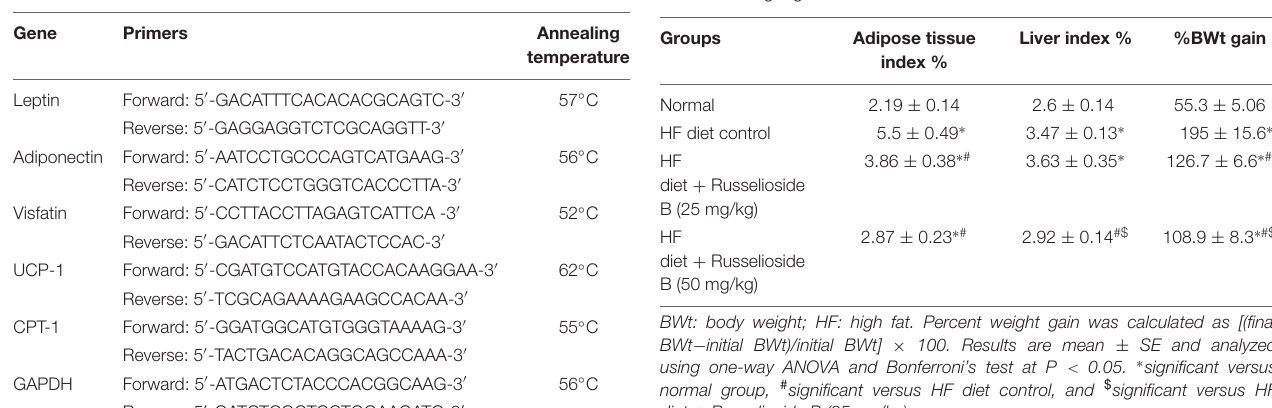
TABLE 1 | Primers and annealing temperatures used in real-time PCR